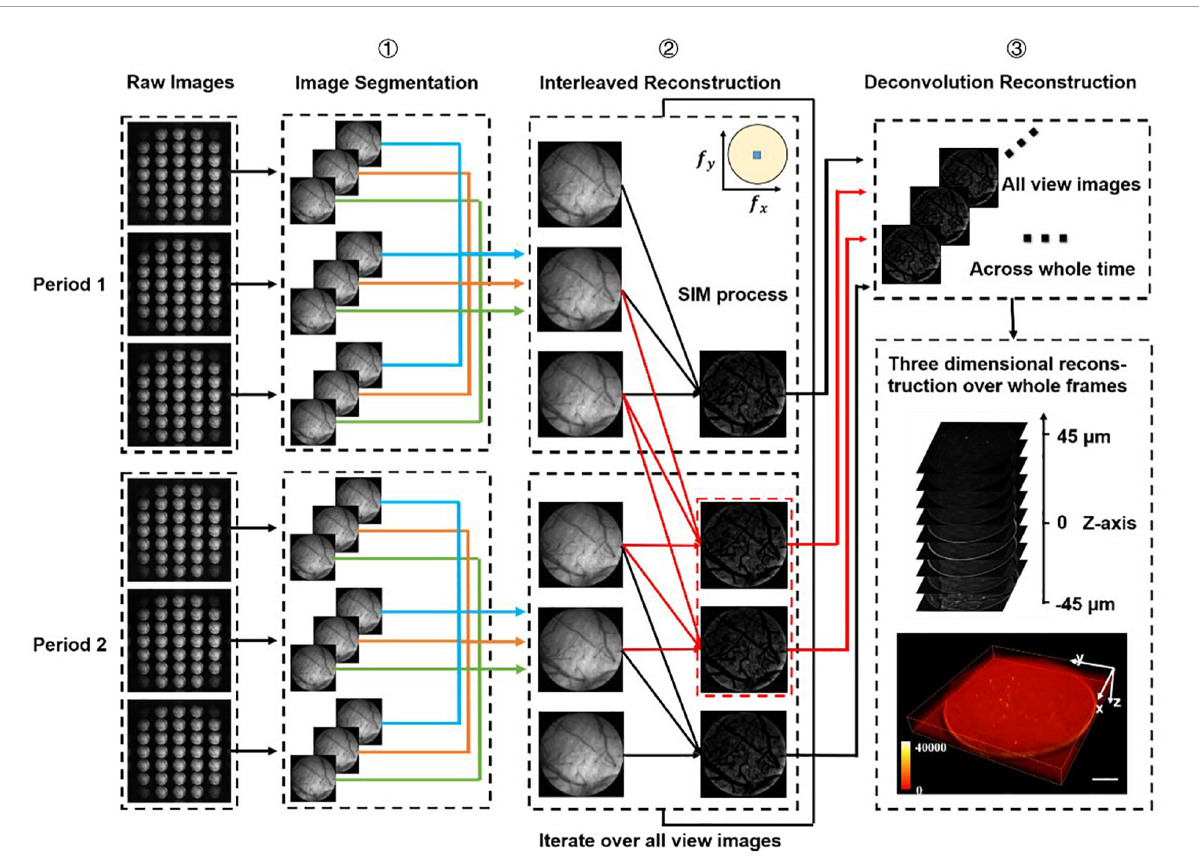
FIGURE2 Data processing procedure. We firstly divide all the raw images (number: 3 n ) into different periods (number: n ), and we have chosen two periods as an example to demonstrate the processing procedure. Step 1: Segment all raw images into sub-images at multi-views. Step 2: Use optical-sectioning algorithms and interleaved reconstruction to achieve optical-sectioning (OS) images without losing frames. The red lines indicate the adding frames recovered by interleaved reconstruction. The number of OS images is 3 n -2 rather than n for each view. This step will iterate until all views sub-images have been processed. Step 3: 3D reconstruction for whole frames by the Richardson-Lucy deconvolution